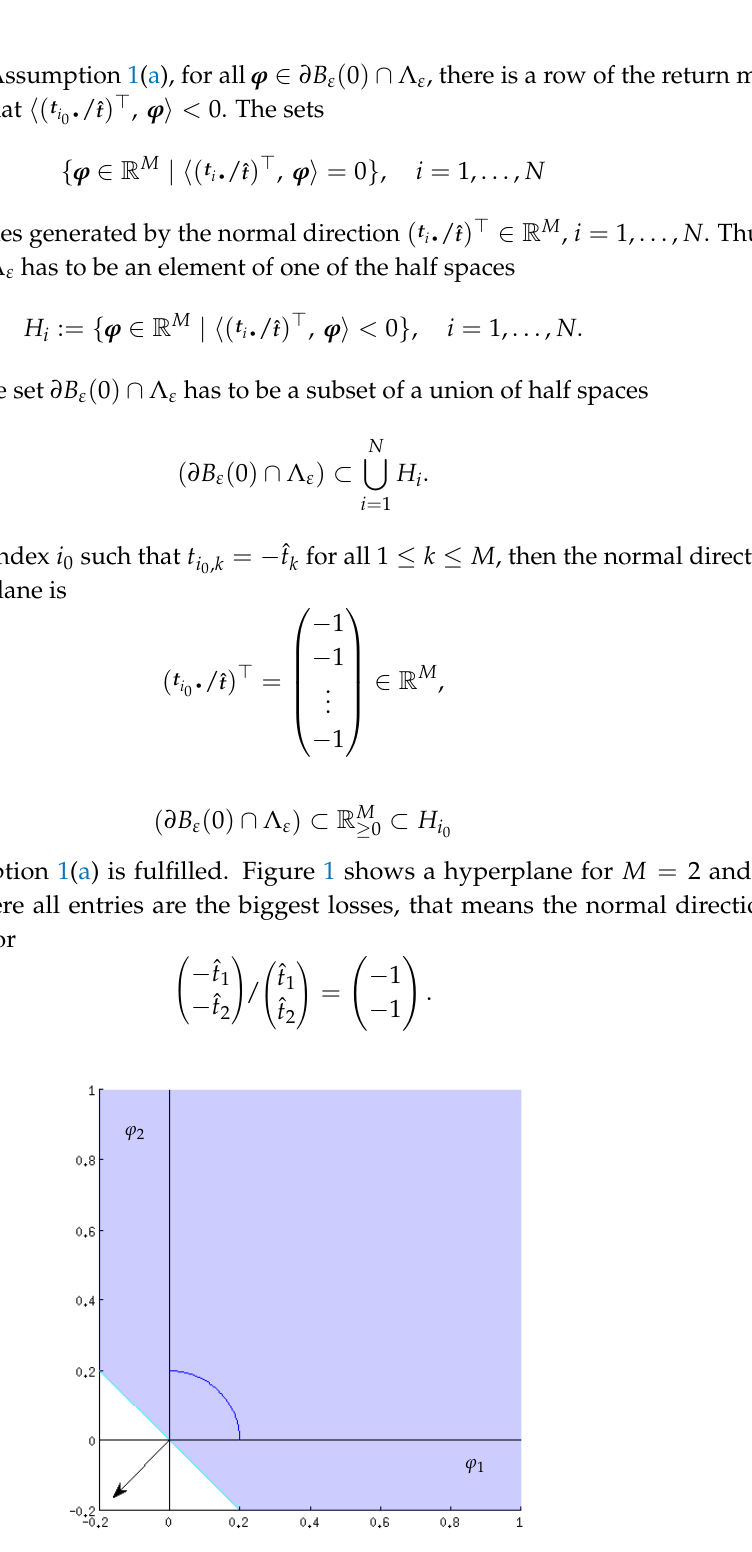
Figure 1. Hyperplane for a return vector consisting of “biggest